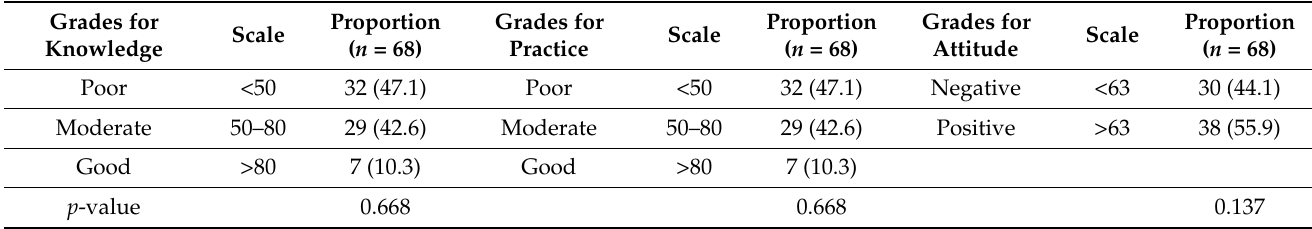
Table 6. Summary of grades for the participants’ KAP levels toward AMR.